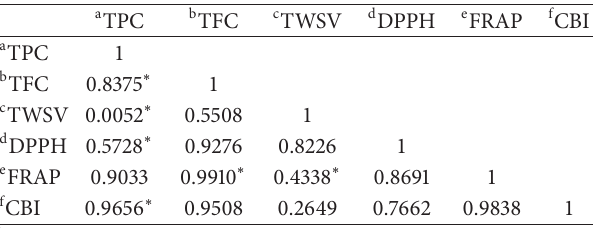
Table 5: Correlation matrix between antioxidant activity and biochemical